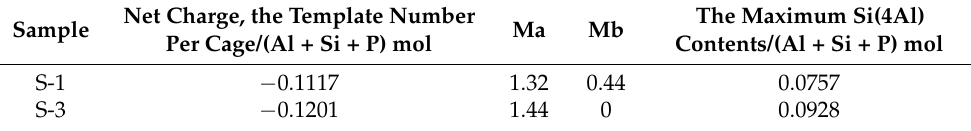
Table 7. The net charge, the template number per cage and the maximum Si (4Al)